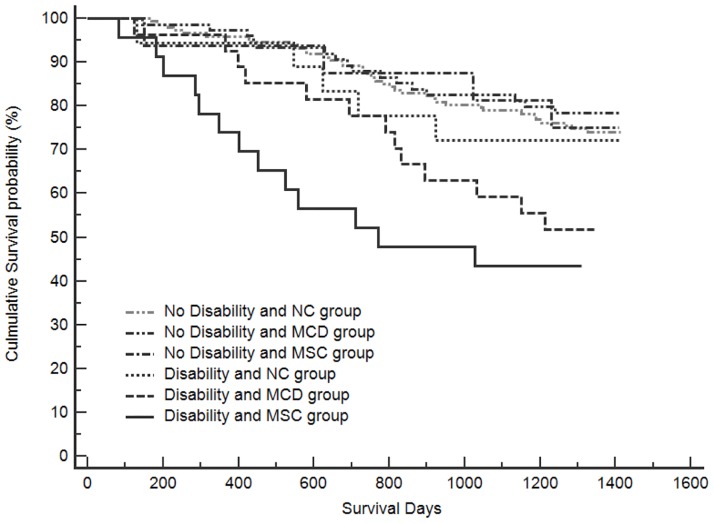
Kaplan-Meier unadjusted survival estimates according to combined function–cognition phenotypes.